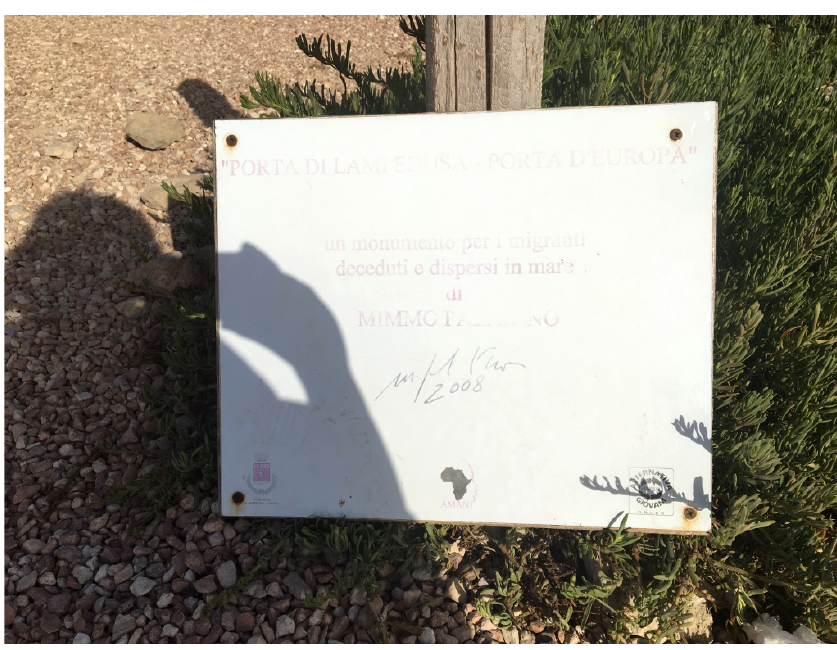
Figure 2. Porta di Lampedusa, Porta d’Europa/Gate of Lampedusa, Gate of Europe (detail), by Mimmo Paladino, 2008. Photo taken by the author in May 2017. The caption reads: “A monument to the migrants who deceased and disappeared in the sea”.